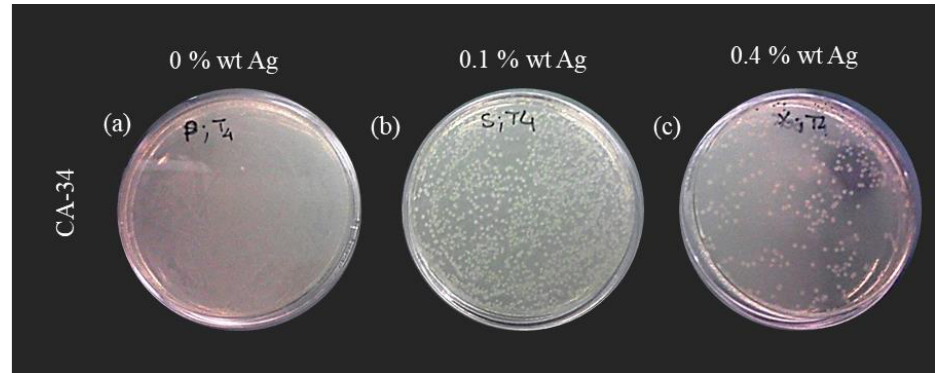
Figure 14. E. coli colonies after the incubation of the suspensions contacting with the membranes (1093 min). ( a ) Silver-free membranes (CA34); ( b ) CA/Ag membranes with 0.1%wt (CA34Ag0.1); and ( c ) CA/Ag membranes with 0.4%wt Ag (CA34Ag0.4). The cell death test was carried out for 18 h and samples of the suspension were